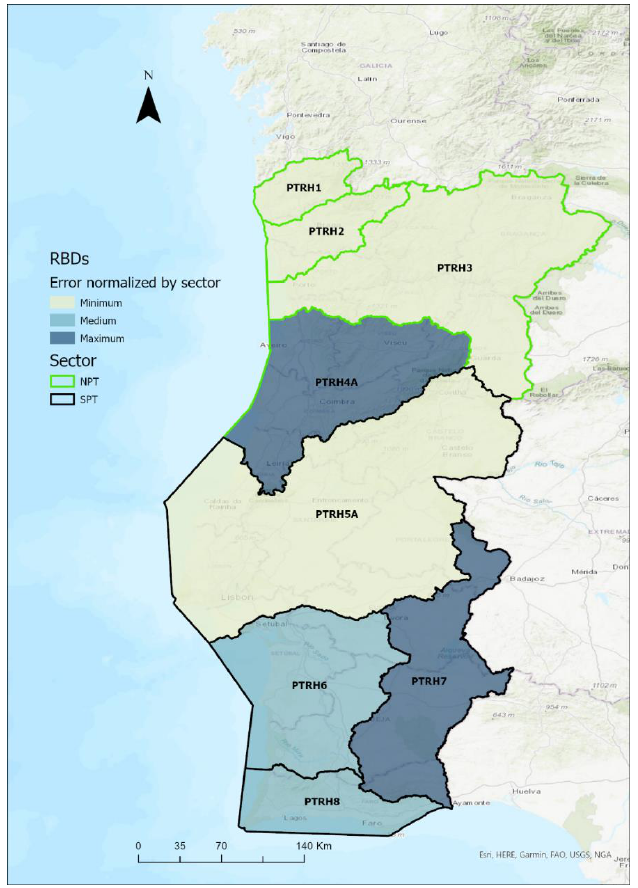
Figure 14. RBD error normalized by the mean error of each sector.